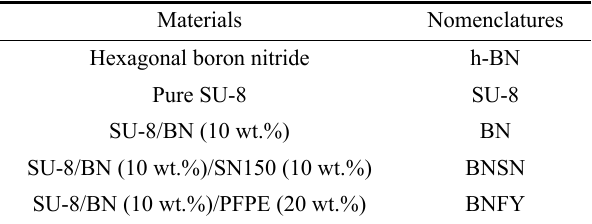
Table 1 Abbreviations used for the different